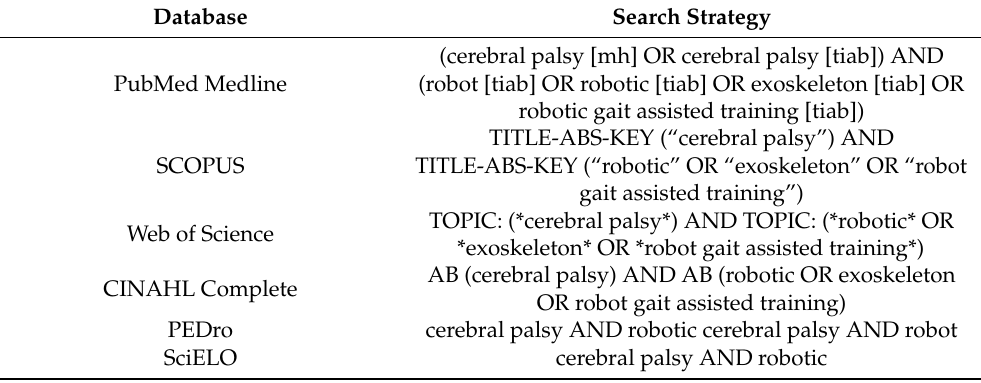
Table 1. Search strategies in